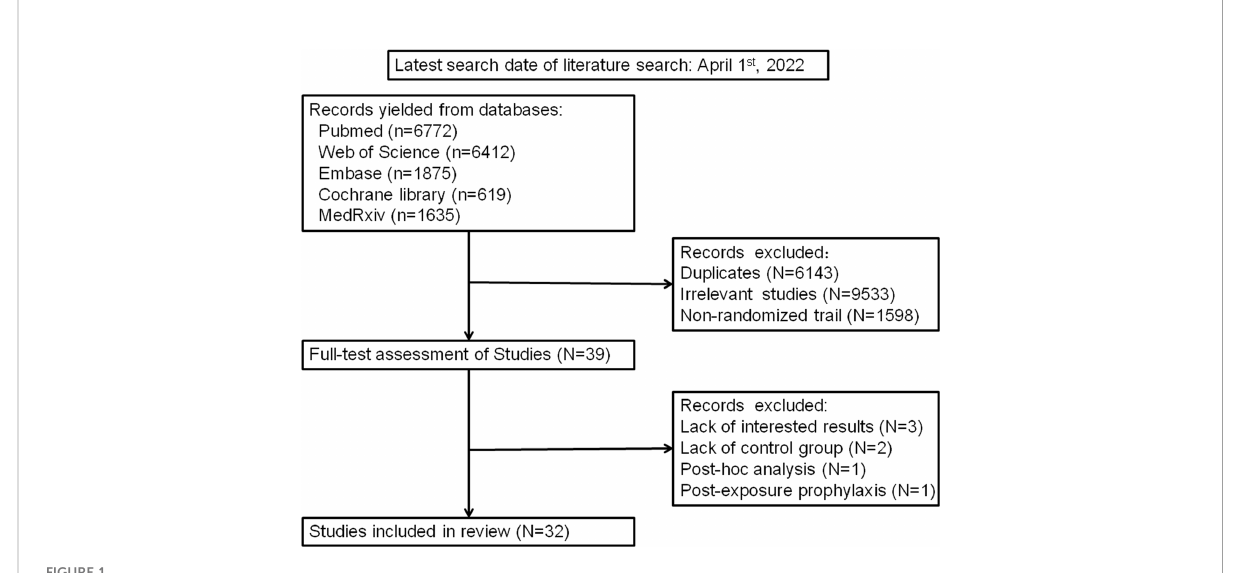
FIGURE 1 The detailed fl ow chart of Literature